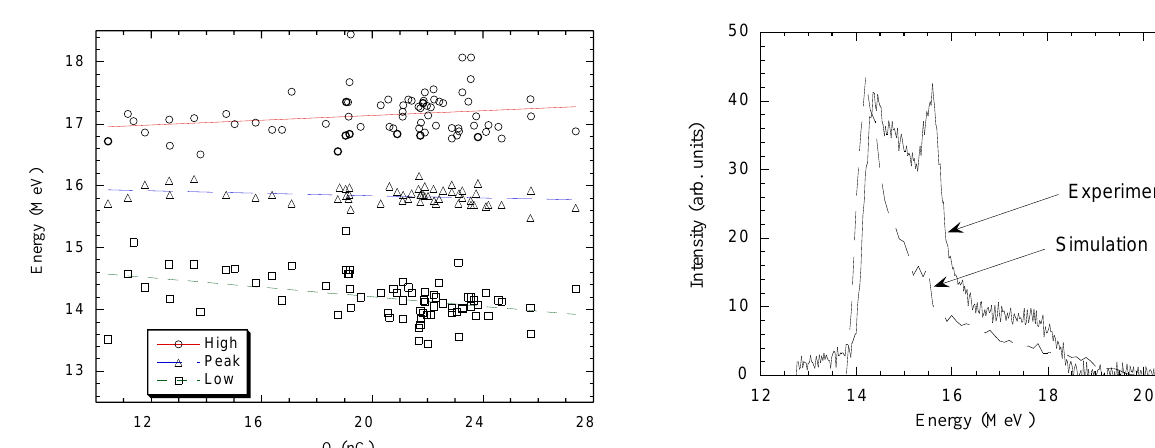
FIG. 11. Measured energy spectrum from the case of Fig. 9(a), compared to simulated (with hybrid superparticle/ plasma fluid code)